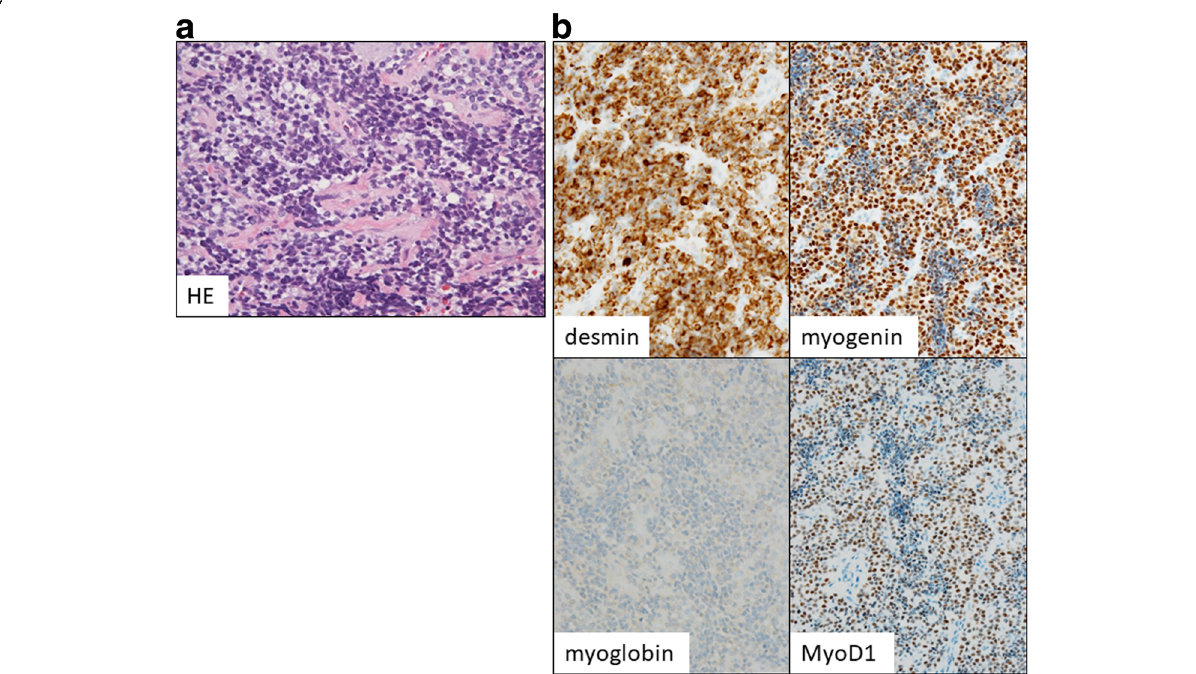
Fig. 5 Pathology of tumor in perineal muscle. a Rebiopsy of perineal muscle indicated similar pathological features characterized as alveolar RMS and confirmed the pathological diagnosis. b An immunohistochemical staining revealed positivity for vimentin, desmin, myoglobin, myogenin and MyoD1 were all positive, whereas CK, synaptophysin, and S-100 were negative. Original magnification of 40×